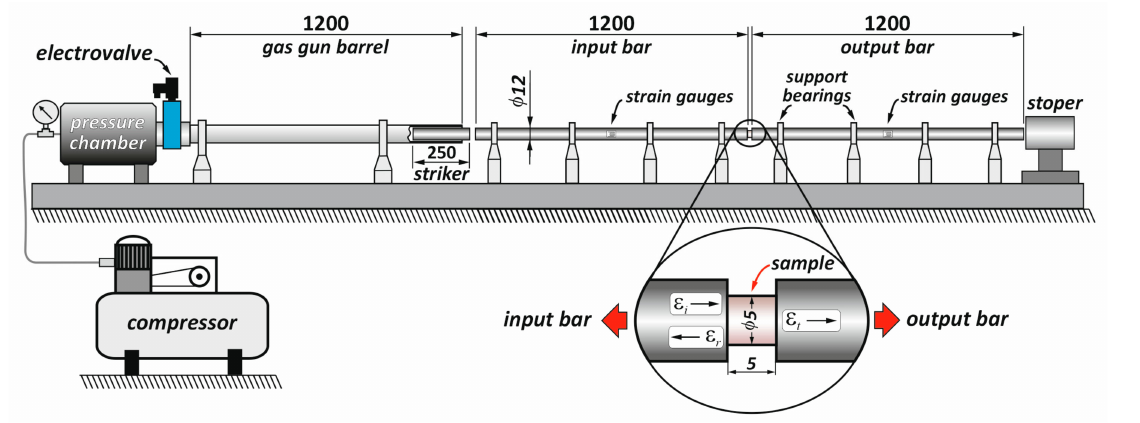
Figure 1. The schematics of the split Hopkinson pressure bar (SHPB) system used in this